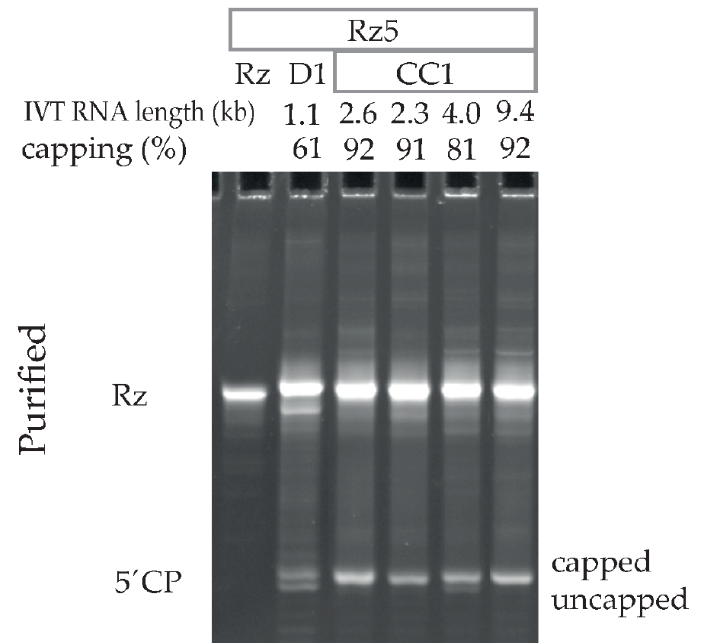
Figure 4. Ribozyme-mediated cleavage effectively assesses capping efficiencies of IVT mRNAs of different lengths. The image shows 21% PAGE, 8 M urea visualization of Rz5-cleaved and silica- column purified TEV, m1 Ψ -containing, beta-S-ARCA (D1) or CleanCap ® Reagent AG (3 ′ OMe), cap1 (CC1) capped IVT mRNAs. The IVT mRNAs ranged from 1.1 to 9.4 kb in length. Rz: Ribozyme; 5 ′ CP: 5 ′ cleavage product.